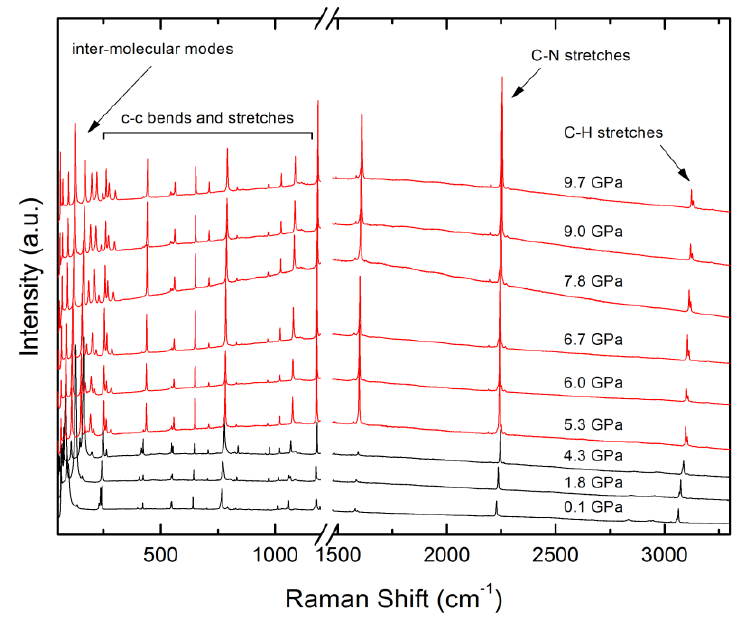
Figure 2. Raman spectra collected on compression of 4-iodobenzonitrile over the entire spectral range studied. Phase I spectra are shown in black, and phase II spectra in red.